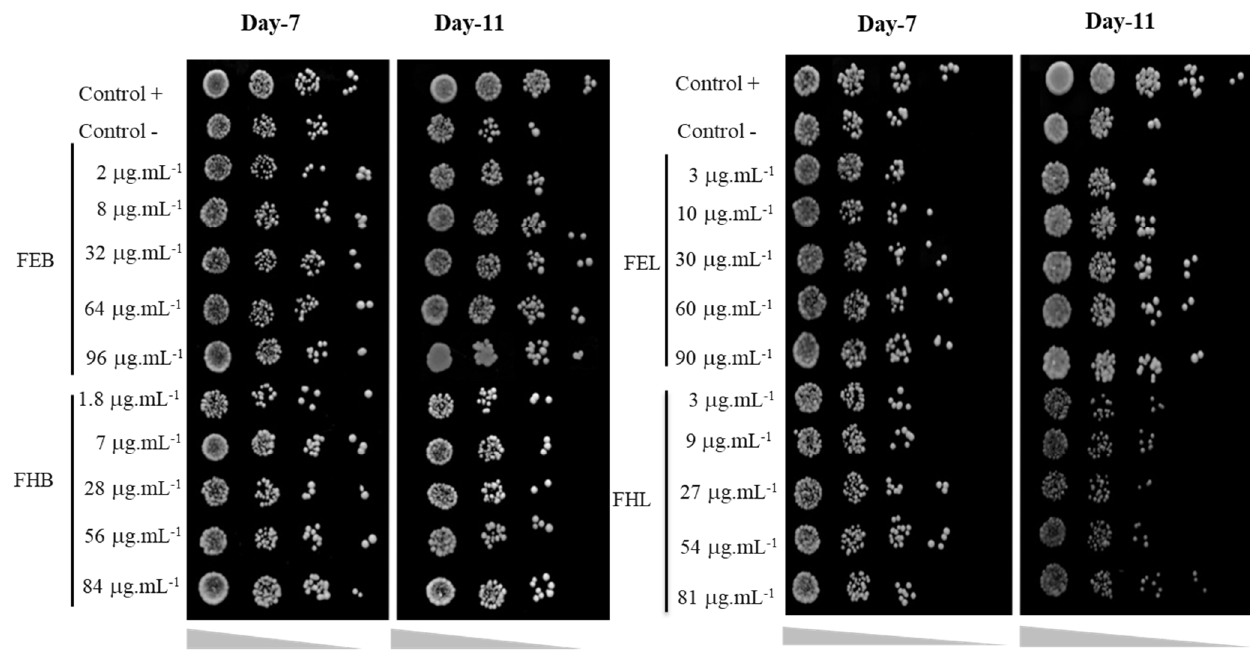
Figure 1. Effect of clove fraction treatment at various concentrations on the viability of S. pombe yeast grown on solid YES medium on the 7th and 11th days of incubation. FHB: clove bud n-hexane fraction, FHL: clove bud n-hexane fraction, FEB: clove bud ethanol fraction and FEL: clove leaf ethanol fraction. Yeasts grown on 0.3% and 3% glucose media without clove fraction were used as positive and negative controls, respectively.